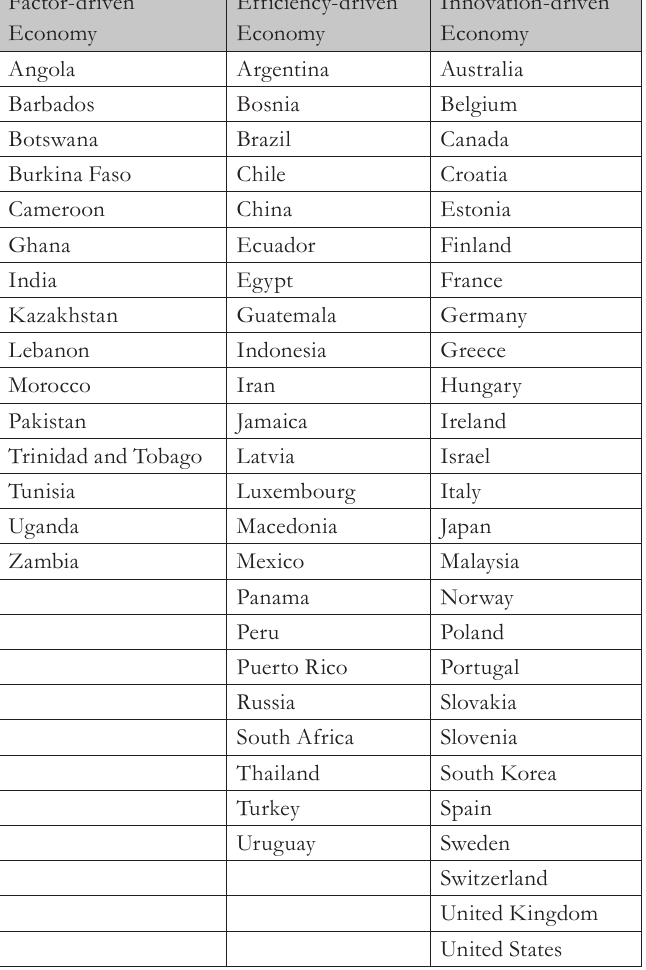
Tab. A – List of sample countries by development stages. Source: GEM database, 2019